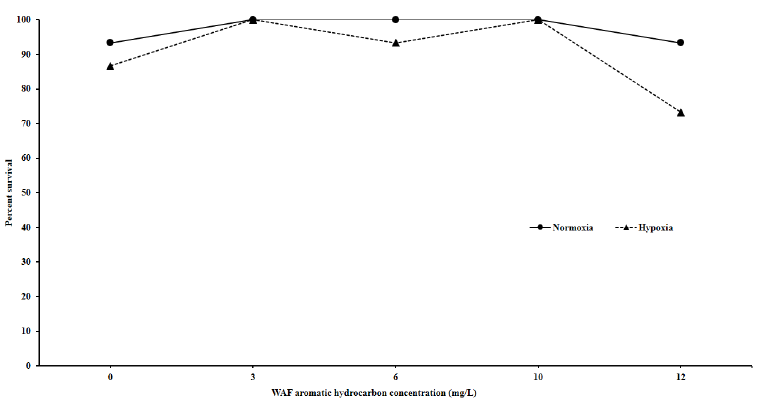
Fig 3. Effects of hypoxia on WAF-induced acute toxicity in sheepshead minnow larvae. WAF was prepared from Southern Louisiana Sweet Crude Oil. Statistical analysis failed to demonstrate any significant effects of either hypoxia or treatment or their interaction on larval survival (p = 0.33, p = 0.076, and p = 0.57